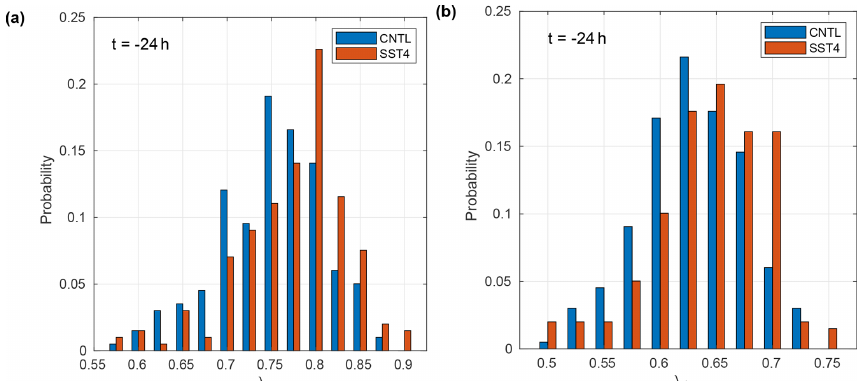
Figure 13. Normalized histograms of the (a) asymmetry parameter and (b) area asymmetry parameter (see text for more details) valid 24h before the time of maximum intensity. Both histograms include values for the 200 strongest extra-tropical cyclones in both experiments. Blue shades show CNTL and red